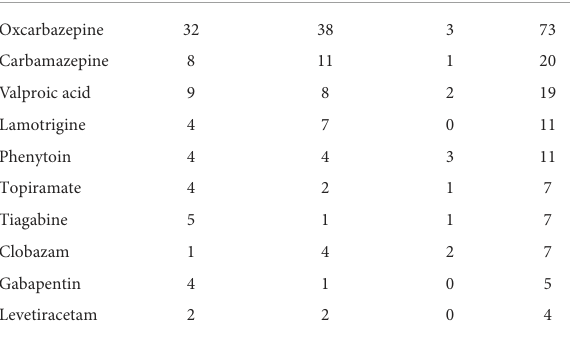
TABLE 8 Reasons for discontinuation in focal epilepsy based on the entire history of antiseizure medication. Lack of efficacy Side effects Other reason